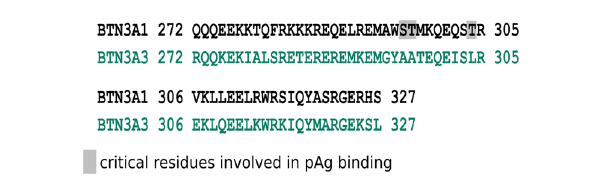
FiGURe 3 | Alignment of sequences encoded by the intracellular juxtamembrane (JTM) domain from BTN3A1 and BTN3A3 isoforms. Amino acids sequence alignment of the JTM domains of BTN3A1 (top line) and BTN3A3 (bottom line). Amino acids are shown in the single letter designation and numbered according to full length nomenclature. Gray boxes show key residues, Ser/Thr 296/297 and Thr 304 , involved in pAg binding in the JTM